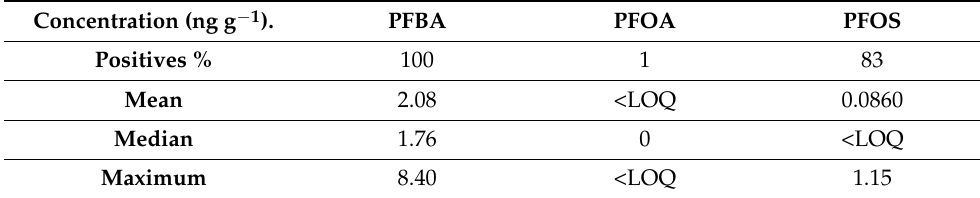
Table 6. Mean, median and maximum concentrations of PFASs detected in the anchovies. Concentration (ng g − 1 ).